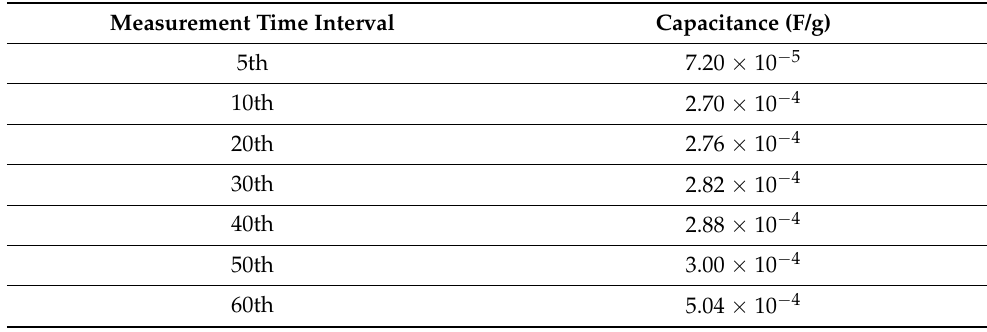
Table 2. CV curves may be used to monitor biofilm growth by computing the Cp values at various intervals of